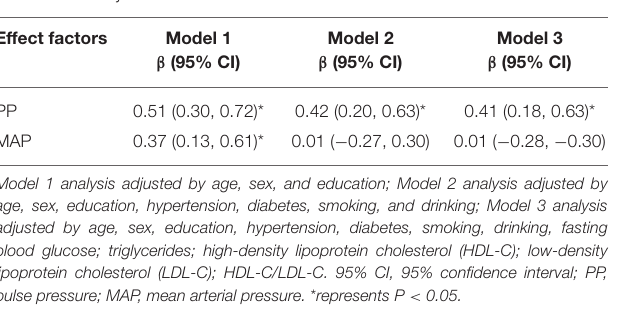
TABLE 4 | Association of mean carotid intima-media thickness ( µ m) with pulse pressure, according to demographic characteristics and risk factor groups in the multivariate